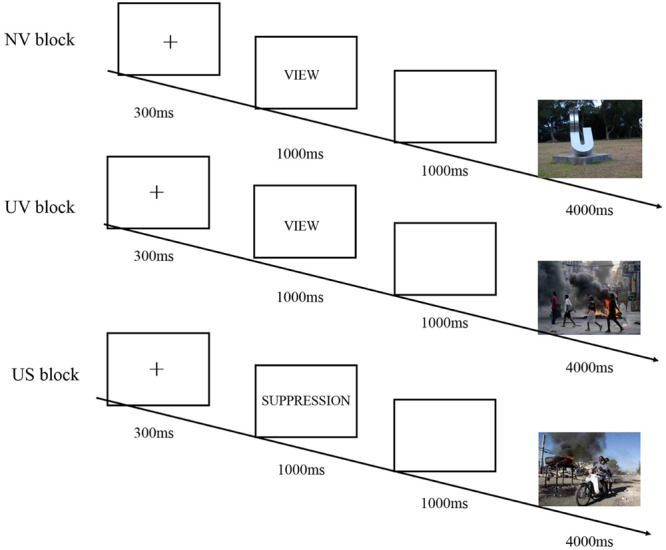
Schematic illustration of the experimental procedure.